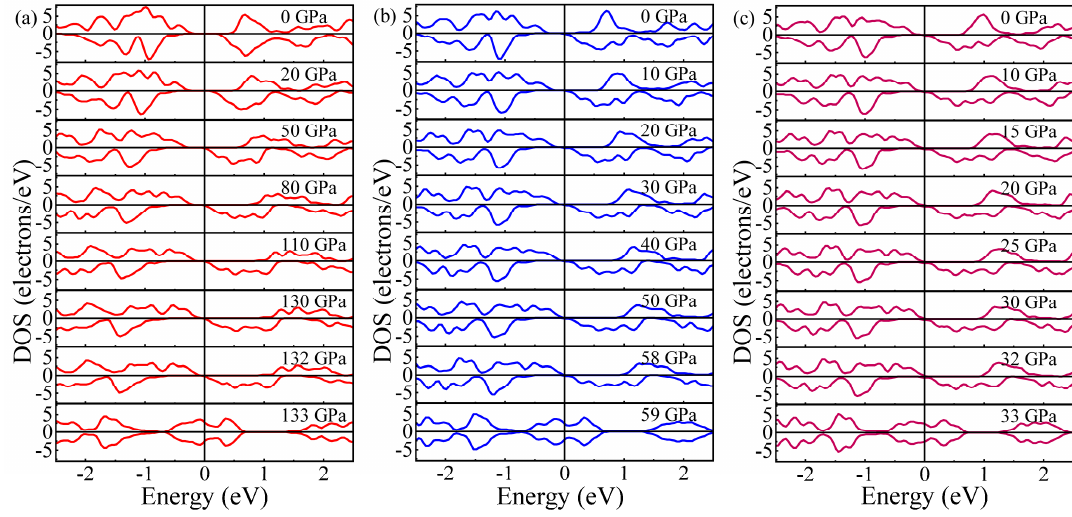
Figure 8. Density of states of type-I ( a ) VFeScSb, ( b ) VFeScAs, and ( c ) VFeScP at various pressures.